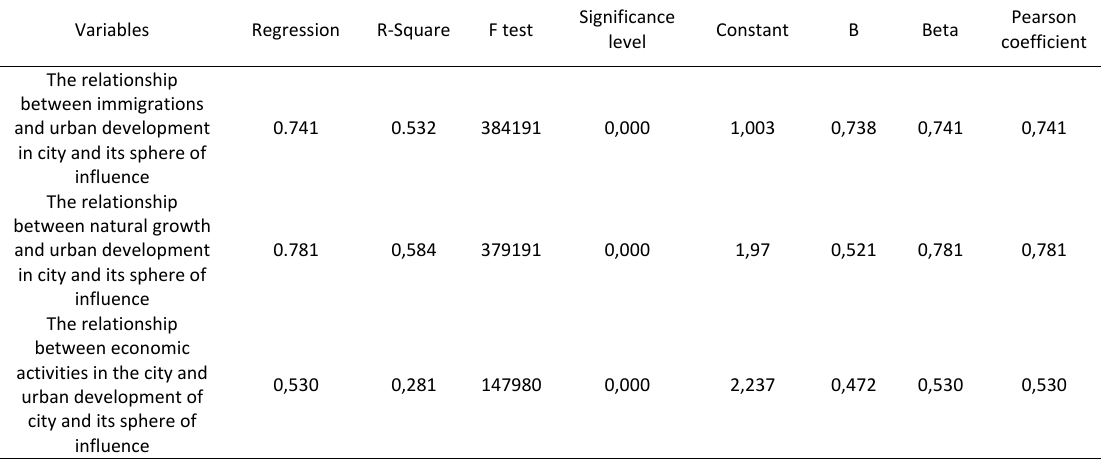
Table 7: the relationship between social and cultural indicators and urban development of Boroujerd and its sphere of influence